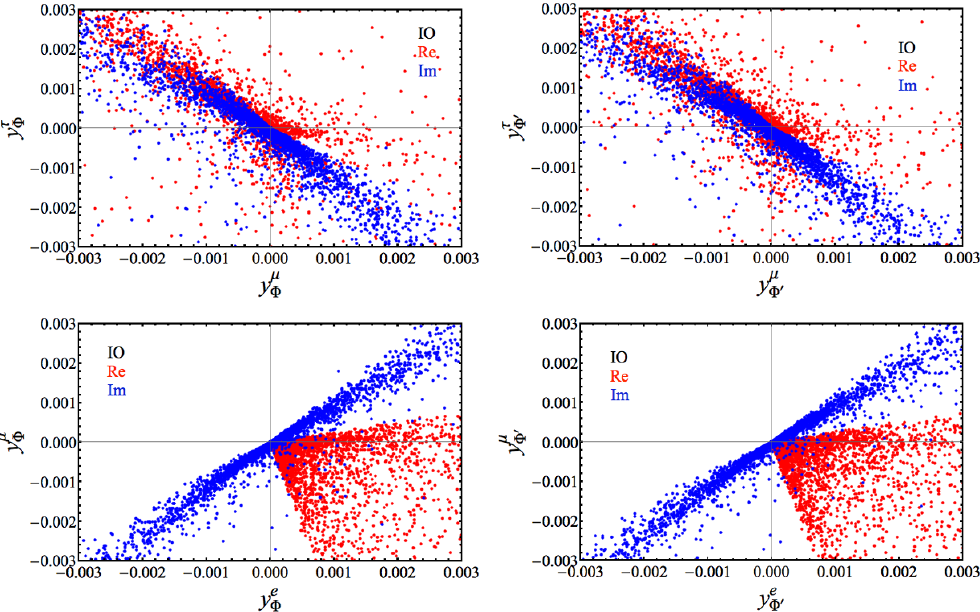
Figure 14 . The same as in (cid:12)gure 13 for neutrino masses with inverted ordering.